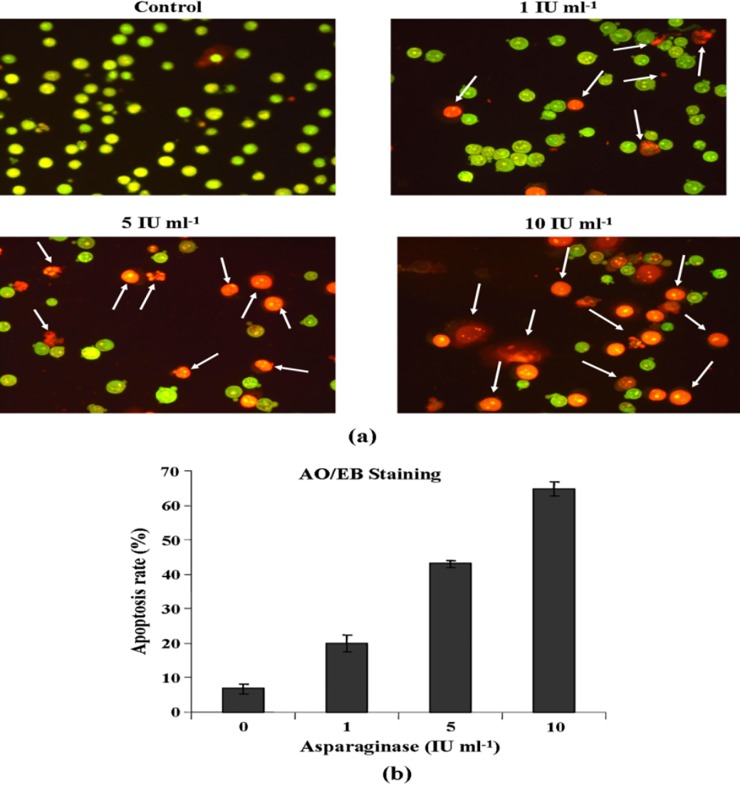
(a) Morphological observation of asparaginase treated HL-60 cells after AO/EB double staining. HL-60 cells treated with indicated concentrations of E. cloacae asparaginase for 24 h, stained with AO/EB solution and immediately visualized under a fluorescence microscope. Live cells showed green color nuclei and apoptotic cells showed orange color nuclei. Photographs were taken by using DP-12 camera. (b) Percentages of apoptosis were calculated during each concentration of asparaginase treatment. Values are means ±SD of three independent experiments.